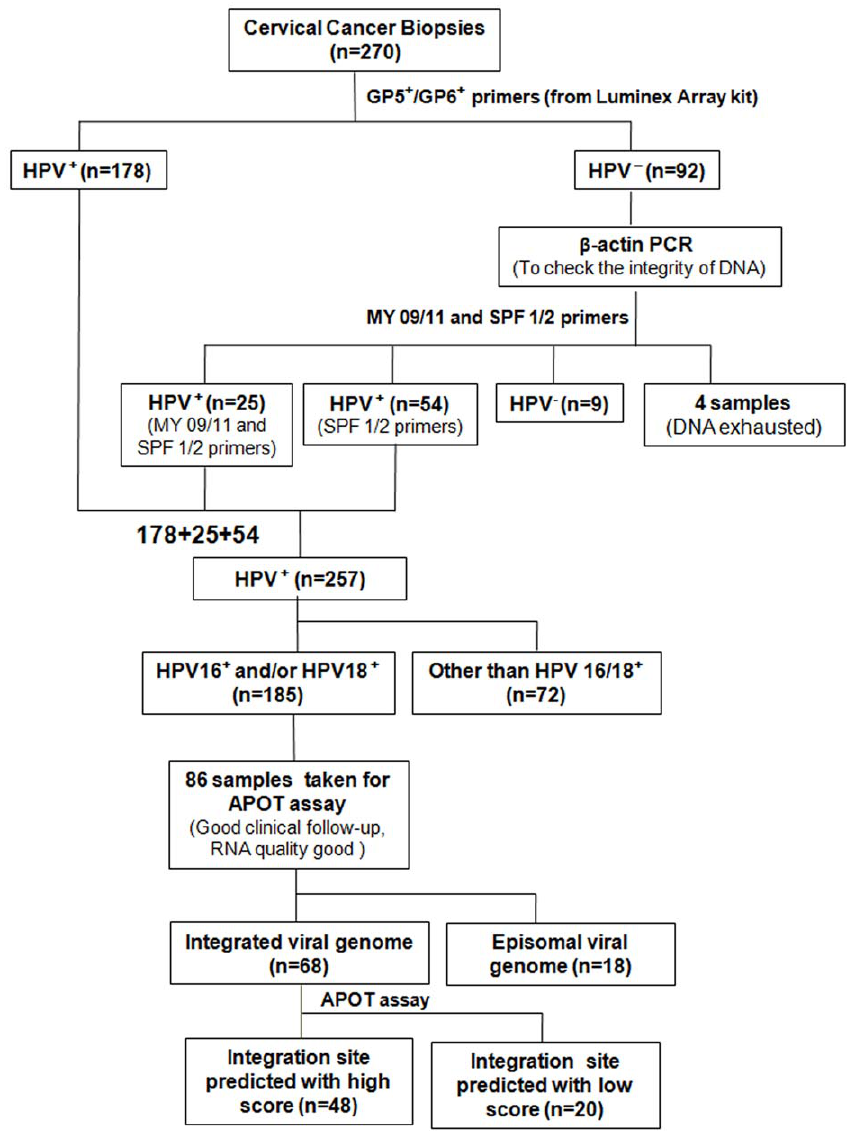
Figure 1. Flowchart depicting summary of the study. Genotyping was carried out on 270 advanced stage cervical cancer samples by high- throughput, GP5 + /6 + primers based luminex array; consensus MY09/11 and SPF1/2 primers. HPV positivity was 95% (257/270). APOT assay was done on 86 HPV16 + and/or HPV18 + samples, with good clinical follow-up and good quality RNA. In 18 samples, only episomal form of HPV was identified, rest 68 hinted toward possible integration. Site of integration could be predicted with high score by BLAST and/or BLAT in 48